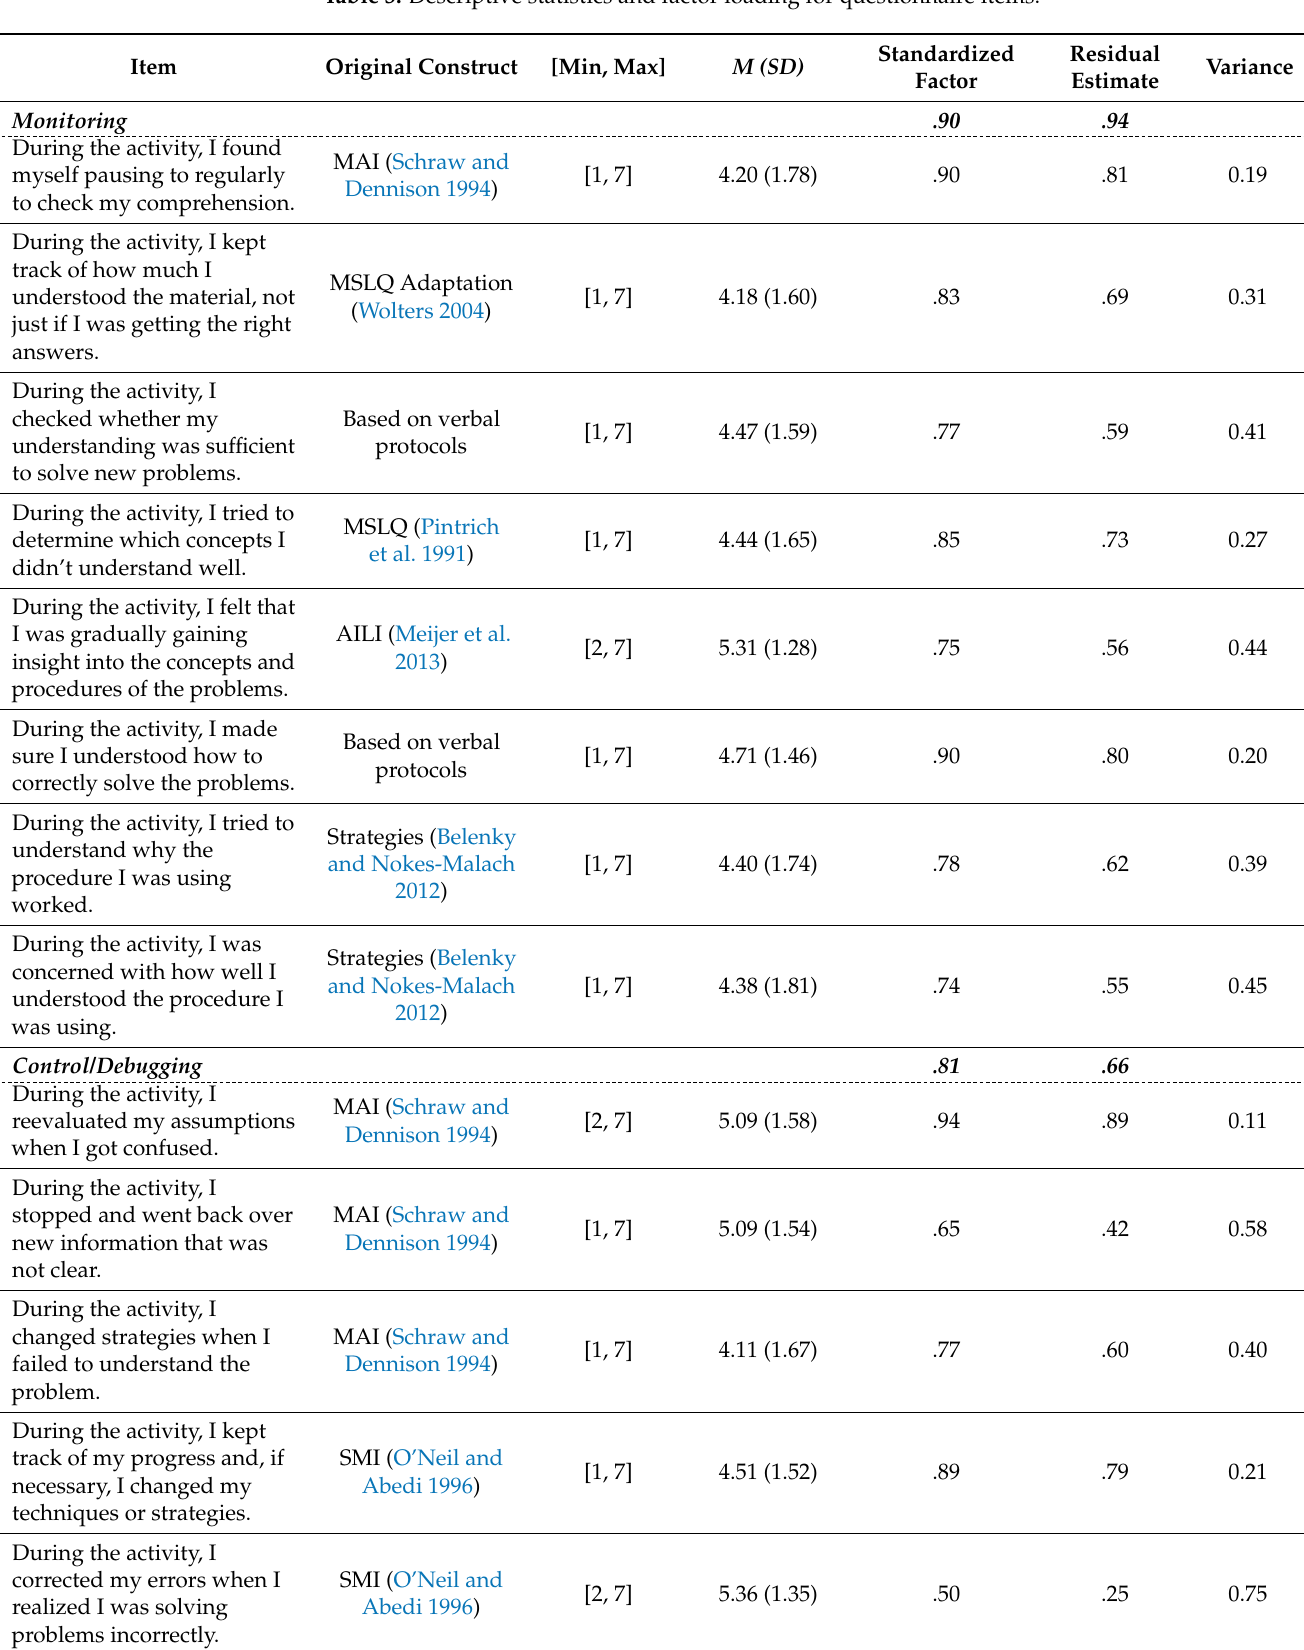
Table 3. Descriptive statistics and factor loading for questionnaire